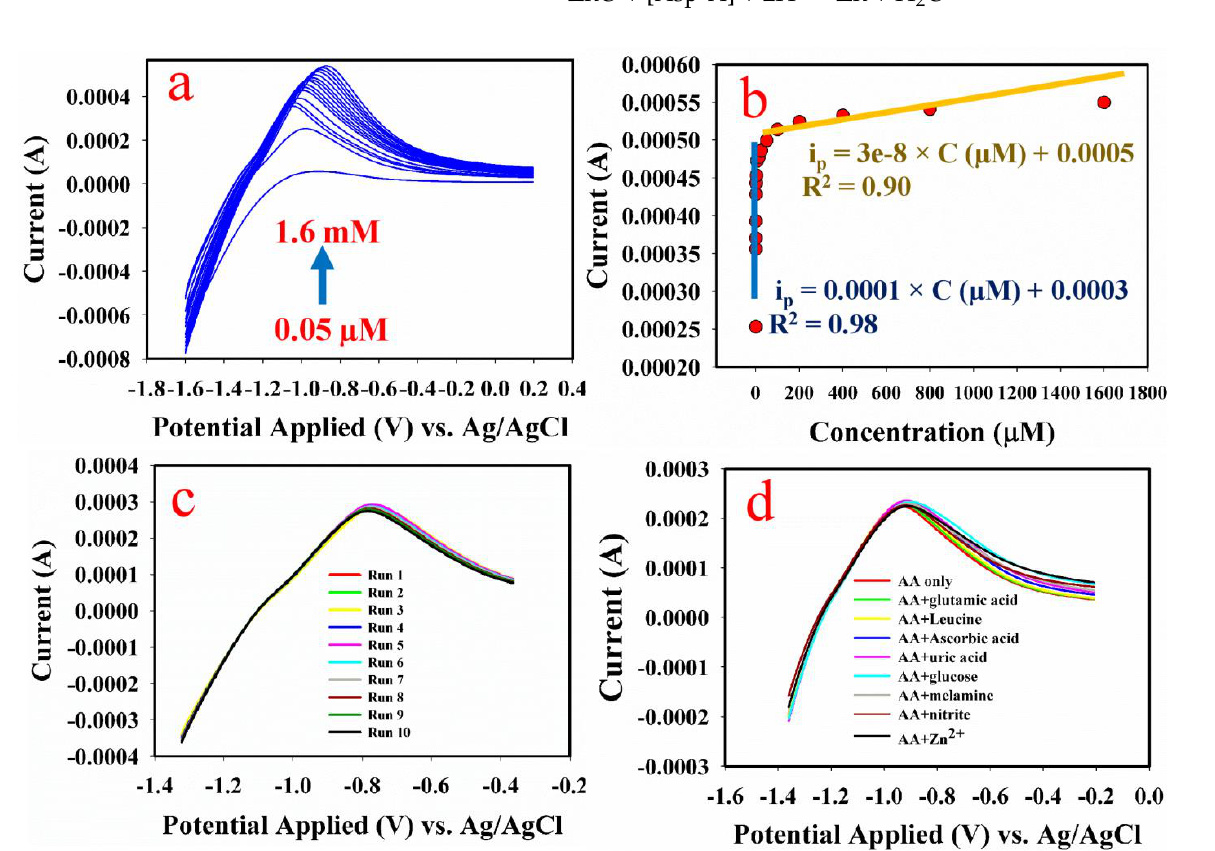
Figure 5. ( a ) Current response of Co 3 O 4 − ZnO nanorod modified GCE, increasing with AA concentration. ( b ) Plot of oxidation peak current against varying AA concentration. ( c ) Current response of Co 3 O 4 − ZnO nanorod in 0.05 µM AA taken 10 consecutive times. ( d ) Current response of Co 3 O 4 − ZnO nanorod in 0.05 µM AA with/without likely interfering species (glutamic acid, leucine, ascorbic acid, uric acid, glucose, melamine, nitrite and Zn 2+ ).